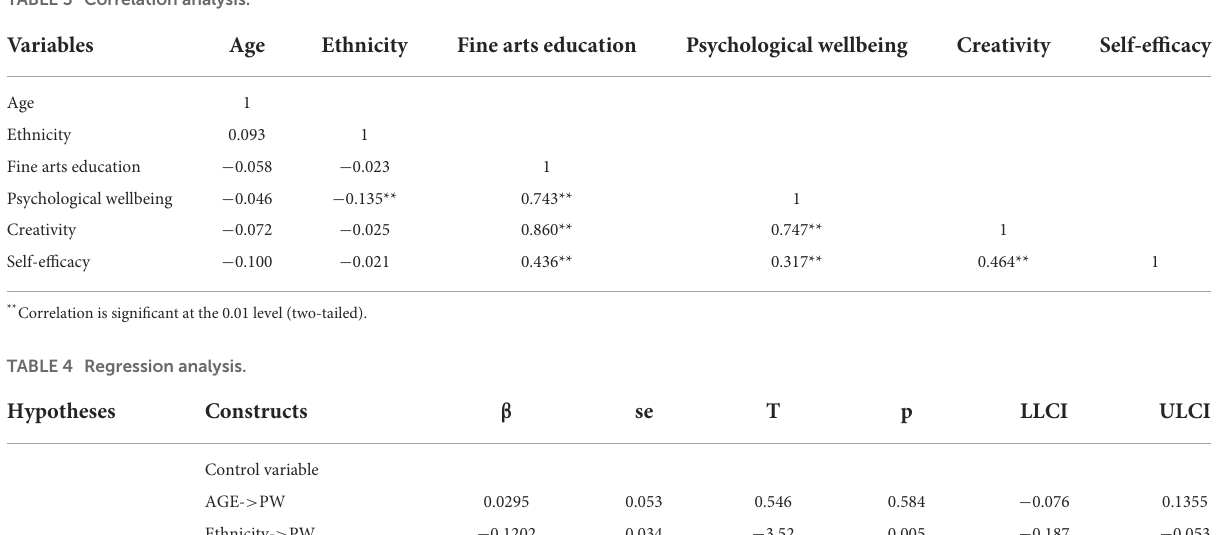
TABLE 3 Correlation analysis.